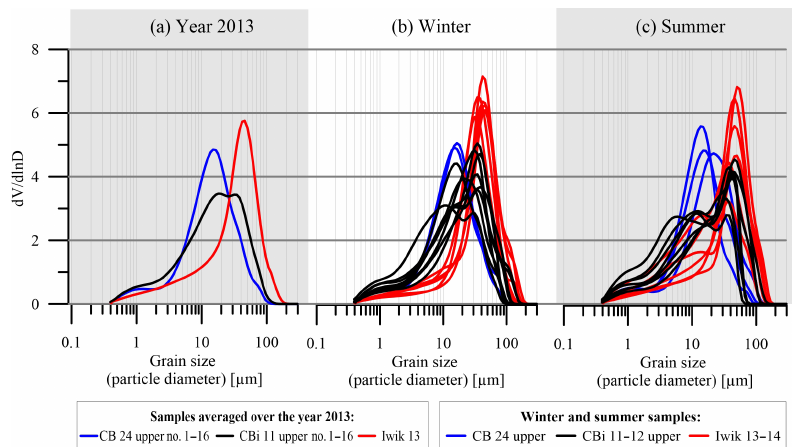
Figure 6. Grain-size distributions of the stations Iwik, CBi and CB (a) averaged for the samples of the year 2013; (b) winter samples; (c) summer samples.